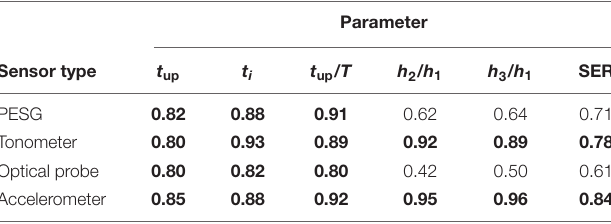
TABLE 6 | ICC of the parameters in the time and frequency domains for intra-observer reproducibility.